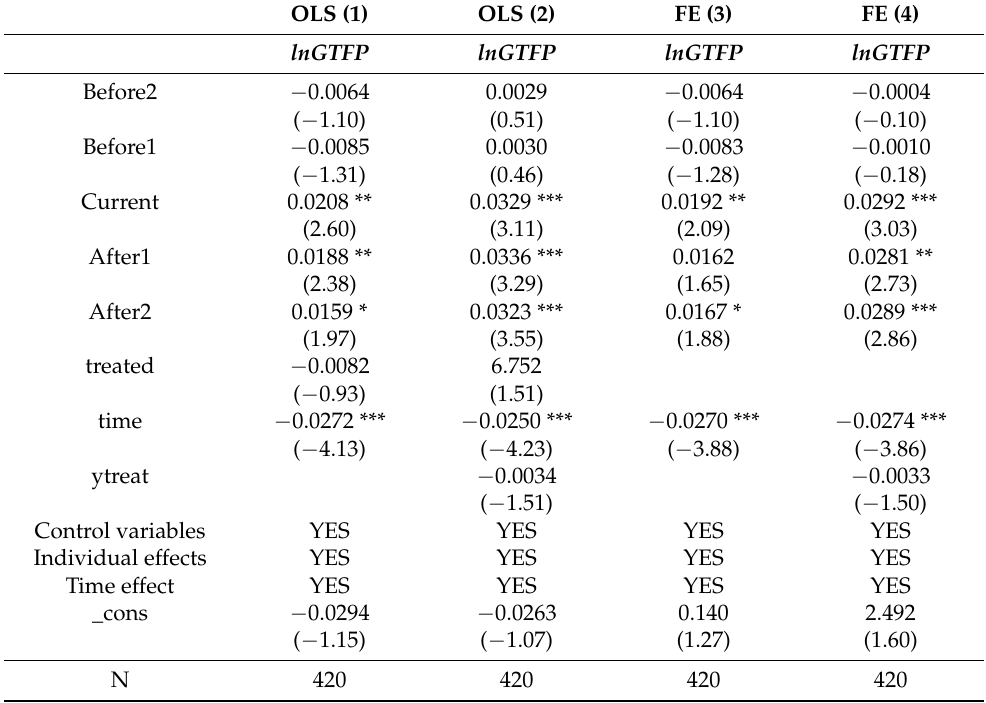
Table 4. OLS and FE estimates of parallel model